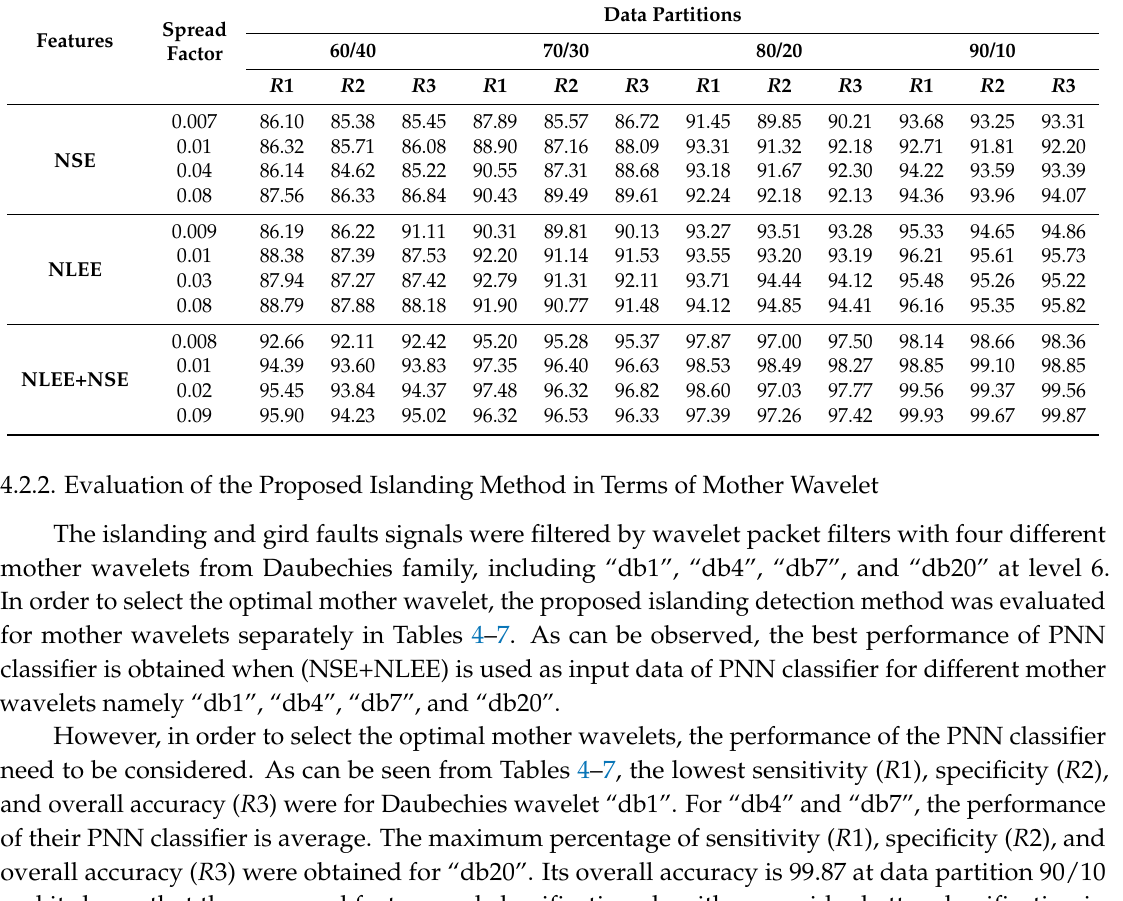
Table 7. PNN classification results at level 6 of wavelet packet decomposition using “db20”.